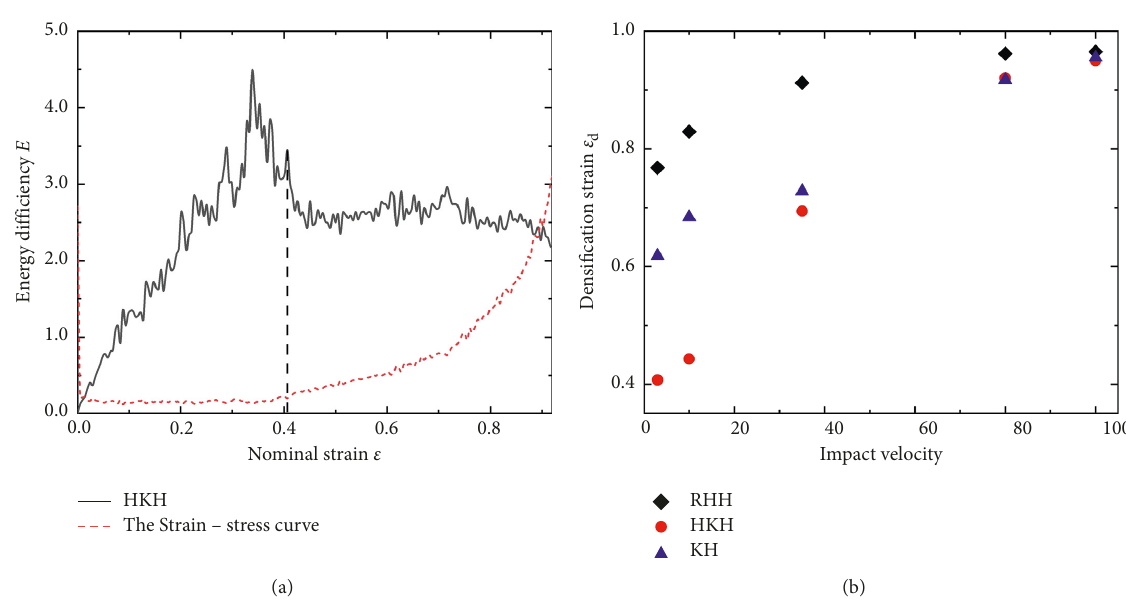
Figure 11: Energy efficiency and densification strain: (a) energy efficiency-strain curve of HKH under an impact velocity V � 3m/s and (b) densification strain of three honeycombs with different impact